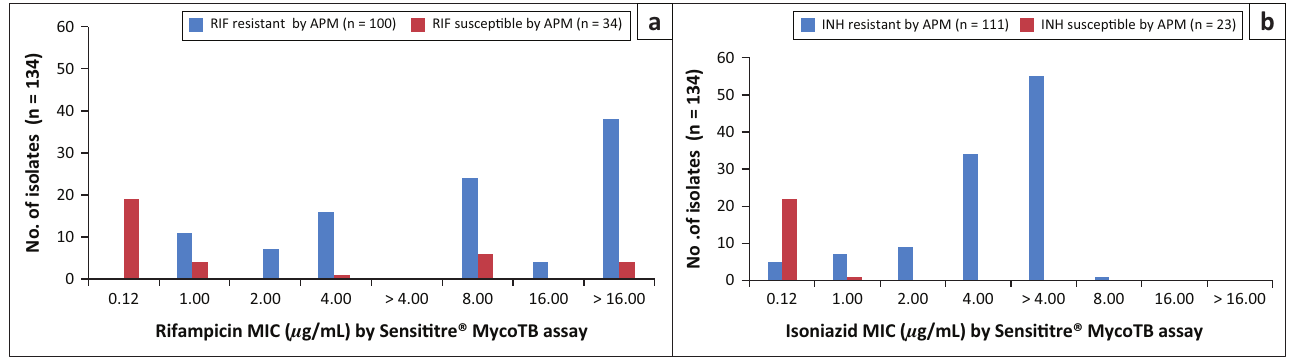
FIGURE 1: Distribution of isolates by minimum inhibitory concentration for isoniazid and rifampicin, Inkosi Albert Luthuli Central Hospital, Durban, South Africa, January 2014 – June 2015. (a) Distribution of RIF-resistant and -susceptible isolates as determined by APM according to their MIC as determined by the Sensititre® MycoTB assay. (b) Distribution of INH-resistant and -susceptible isolates as determined by APM according to their MIC as determined by the Sensititre® MycoTB assay. TABLE 1: Comparative performance of the Sensititre® MycoTB assay and agar proportion method on multidrug-resistant and extensively drug-resistant tuberculosis isolates, Inkosi Albert Luthuli Central Hospital, Durban, South Africa, January 2014 – June 2015. Antimicrobial drug